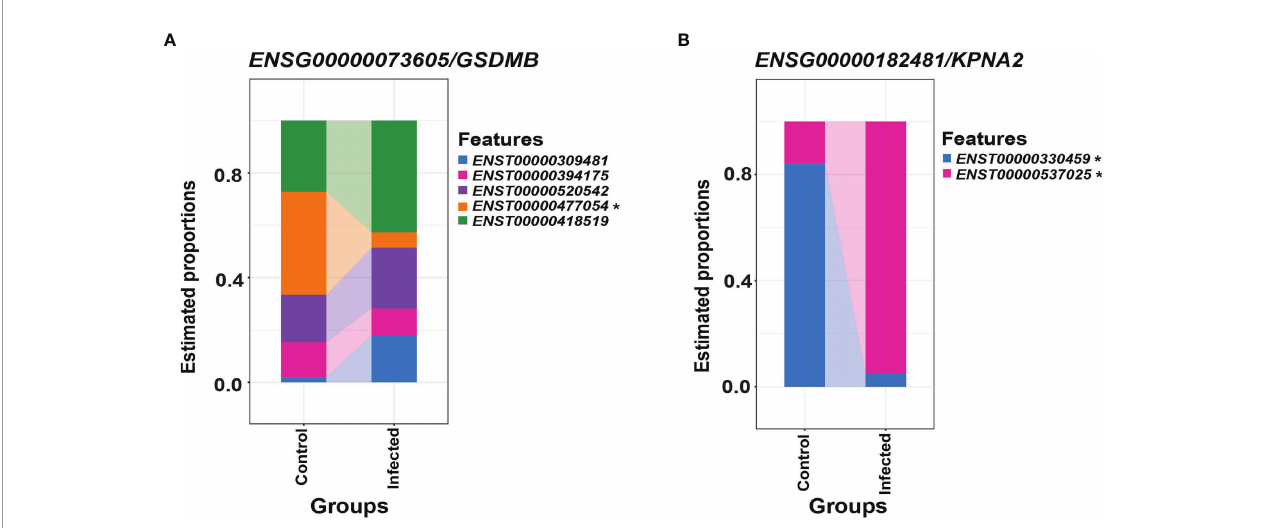
FIGURE 6 | Differential transcript usage in the Calu-3 48 hpi dataset. (A) Differential estimated proportions of transcripts of ENSG00000073605 / GSDMB between control and infected cells, where the ENST00000477054/GSDMB-208 transcript was found to decrease in transcript usage in infected cells relative to control cells. (B) Differential estimated proportions of transcripts of ENSG00000182481/KPNA2 between control and infected cells, where the ENST00000300459 / KPNA2-201 and ENST00000537025 / KPNA2-202 transcripts were found to decrease and increase in transcript usage in infected cells relative to control cells, respectively. The differential transcript usage events included protein-coding, processed and retained-intron transcripts, which reveals involvement of alternative splicing. Furthermore, these events were involved in genes previously implicated in SARS-CoV-2 infections, suggesting the importance of exploring the transcriptome at the isoform level. Transcripts with signi fi cant differential transcript usage between conditions are marked with an asterisk (padj < 0.05). Related to Table 5